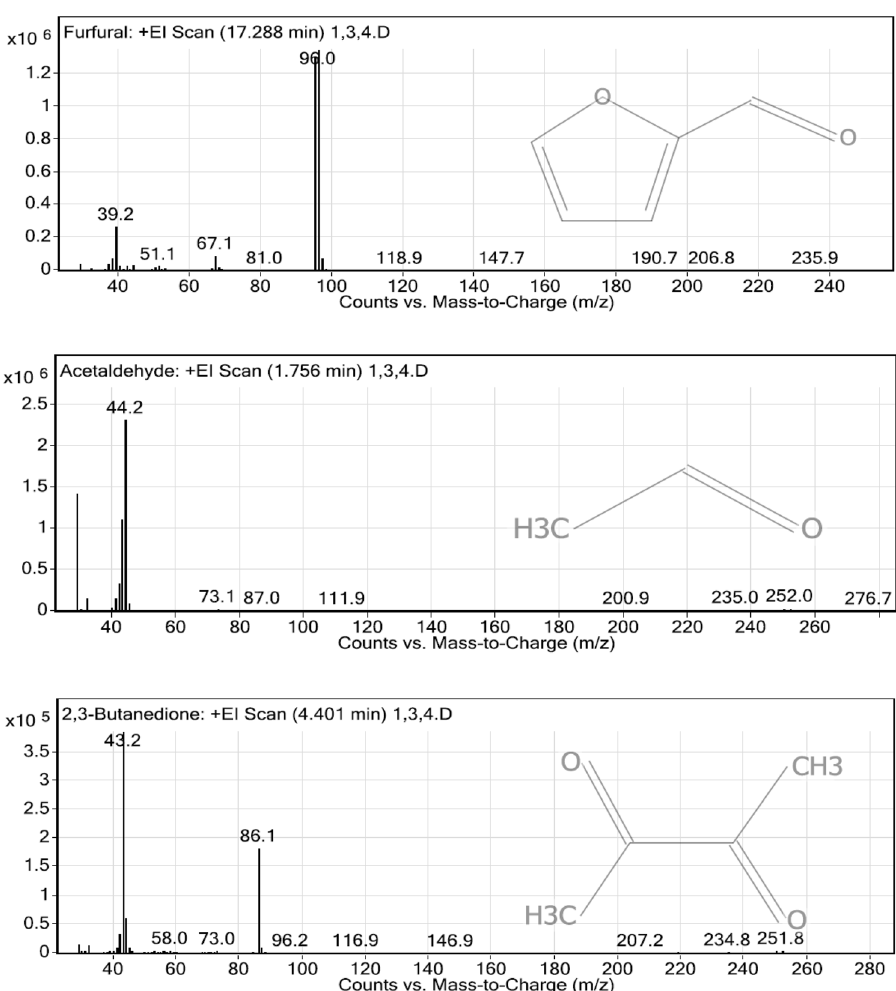
Figure 4. The most abundant volatile organic matters from alkaline pre-treated rice straw waste followed by enzymatic